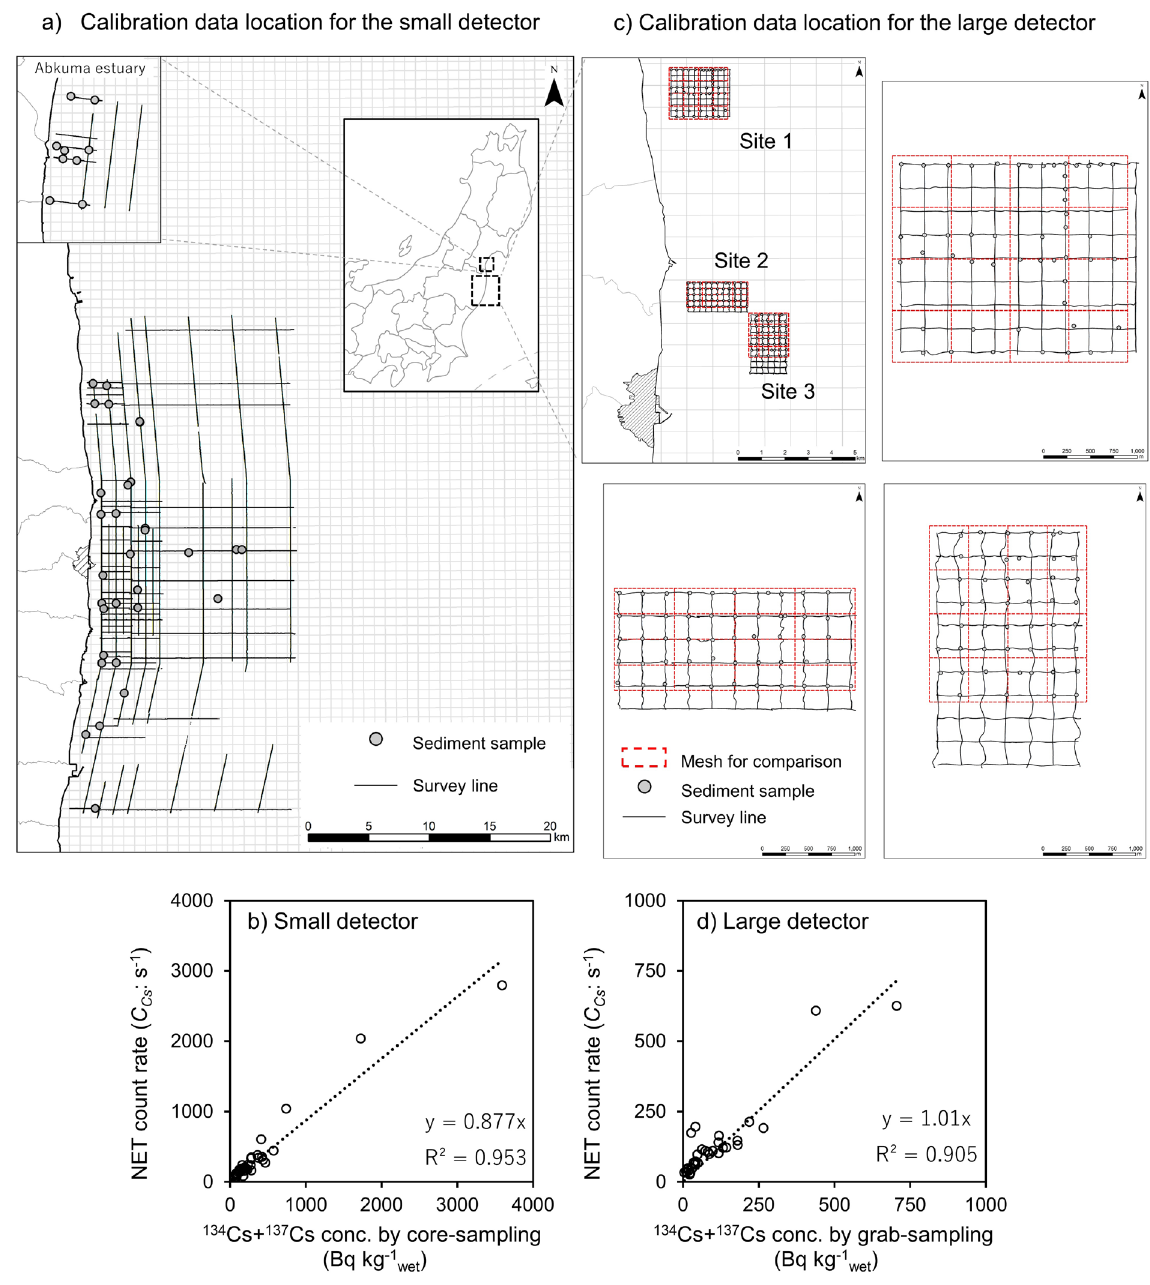
Figure 8. The survey line of the towed radiation survey system and the locations of ( a ) sediment core and ( b ) grab samples for obtaining the calibration data. The linearity of radiocesium concentration using ( c ) small detector and ( d ) large detector. Map created with ESRI ArcGIS 10.8.0. B Basemap sources: ESRI ArC GIS on-line (( c ) Esri survey lines, was averaged for comparison with C Cs , which was averaged in 100 m at the center of the sampling location. A scatter diagram of the radiocesium measurement result from the sediment surface to 10 cm of the sediment core sample and C Cs is shown in Fig. 8b. In this figure, the actual sample measurement and C Cs corre- late well from 30 Bq kg −1 to 3500 Bq kg −1 . This approximate straight line inclination was defined as a conversion factor ( CF : 0.877 cps Bq −1 kg wet ). In 2020, a towed radiation survey with a large detector was conducted within the survey lines, as shown in Fig. 8c. The radiocesium measurement result from the sediment surface (0 cm) to 10 cm of the grab sample collected at an intersection of the survey lines was prepared for comparison with C Cs . We selected a grab sample instead of a core sample because many samples are needed due to the low radiocesium concentration in the sediment. The C Cs and radiocesium concentration of the actual sample in the selected grid (marked by red line in Fig. 8c) were averaged and compared. A scatter diagram of the radiocesium measurement result in the sediment surface of the grab sample and C Cs is shown in Fig. 8d. In this figure, the actual sample